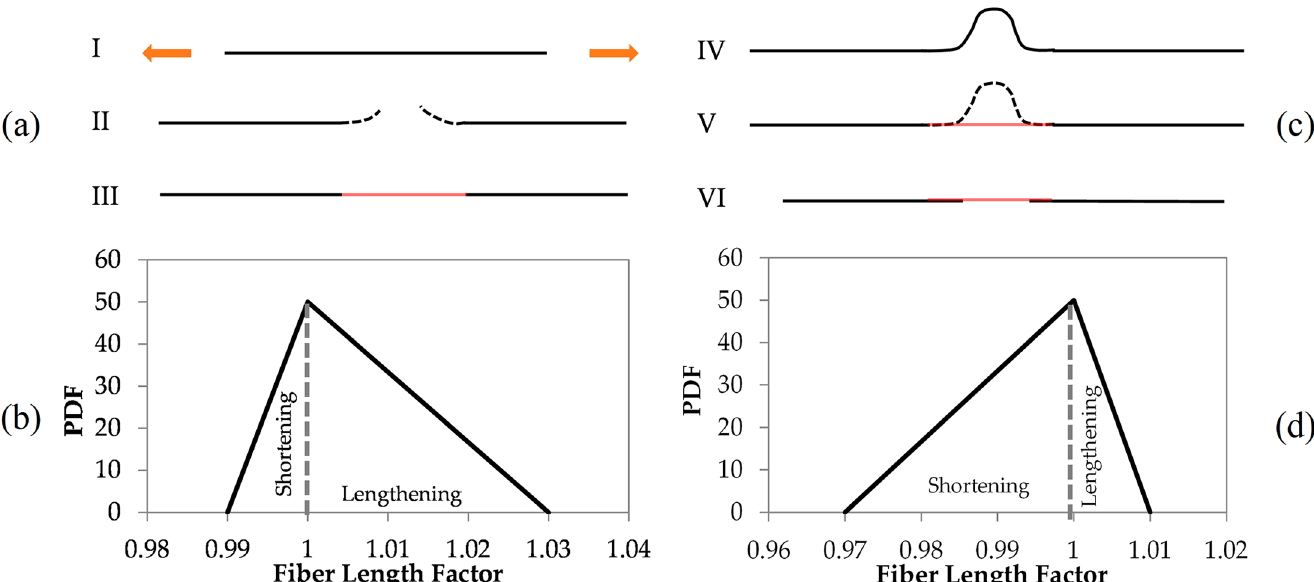
Fig 4. Collagen fiber remodeling. a) remodeling of collagen fibers by mechanical damage and repair, (I) shorter fibers are subject to higher strains, (II) fiber focal damage under mechanical strain forming a gap, (III) fiber repair at a longer length by filling in the gap with new collagen, b) repair probability density function following mechanical damage, quantifies the bias toward fiber lengthening, c) remodeling of collagen fiber by proteolytic damage and repair, (IV) longer fibers are subject to lower strains, thus more likely to be degraded by proteases, (V) new collagen forms across the gap while excess fiber is degraded resulting in a shorter fiber (VI), c) repair probability density function following proteolytic damage quantifies the bias towards fiber